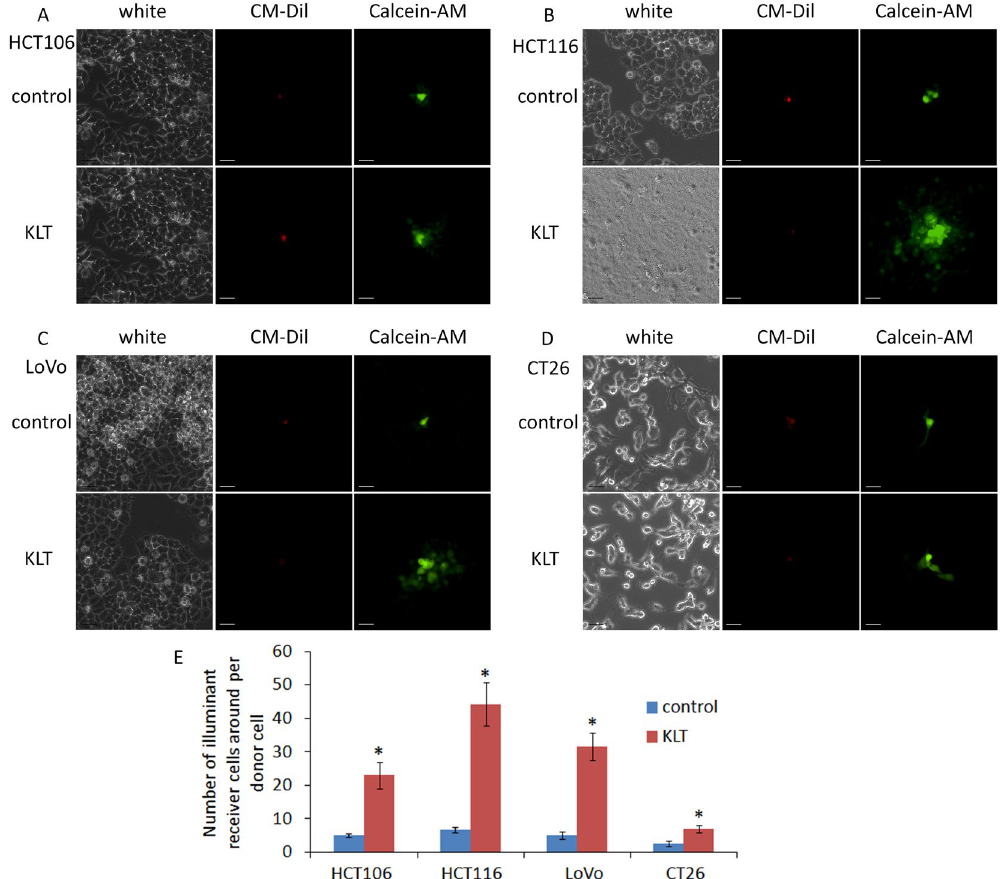
Figure 5. Results of “Parachute” dye-coupling assay. The four cell lines were treated with KLT and GJIC function was measured. The scale bars represent 20 μ m. ( A ) HCT106; ( B ) HCT116; ( C ) LoVo; ( D ) CT26; and ( E ) GJIC function in the four cell lines. Columns represent the mean from five independent experiments and bars represent standard deviations. Average number of cells with green fluorescence in each group were compared by student’s t-test. * P < 0.05, significantly different from control group. GJIC functions of all KLT treated cells were higher than control